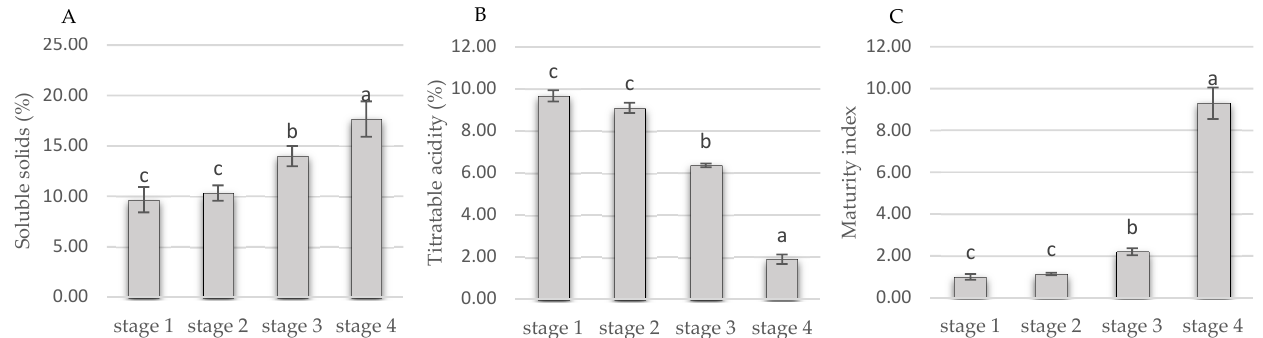
Figure 1. Vaccinium stenophyllum Steud. fruit quality attributes during ripening. ( A ) Soluble solids; ( B ) titratable acidity; ( C ) maturity index. The mean ± standard deviation is shown; different letters indicate significant statistical differences. An analysis of variance (ANOVA) was performed, and means were separated using the Tukey test ( p ˂ 0.05).